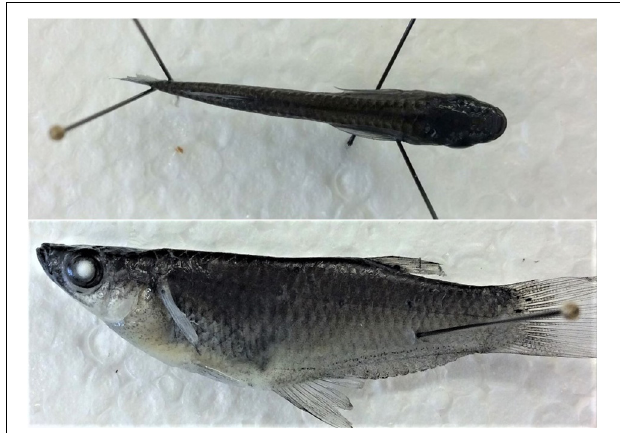
FIGURE 1 | Photos of the lateral and dorsal view of a female Alfaro cultratus . Dorsal view shows laterally compressed body shape.